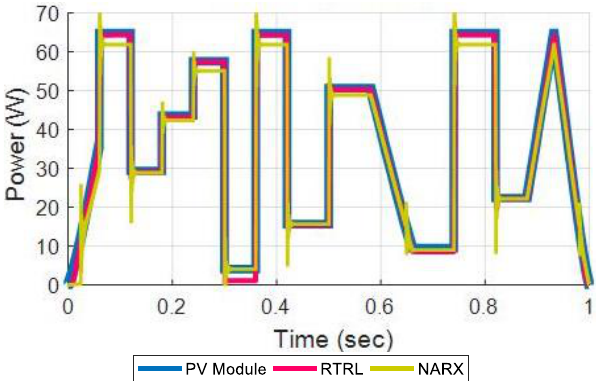
Figure 22. Results obtained with the RTRL and NARX controllers for a signal of variable irradiance and constant temperature.